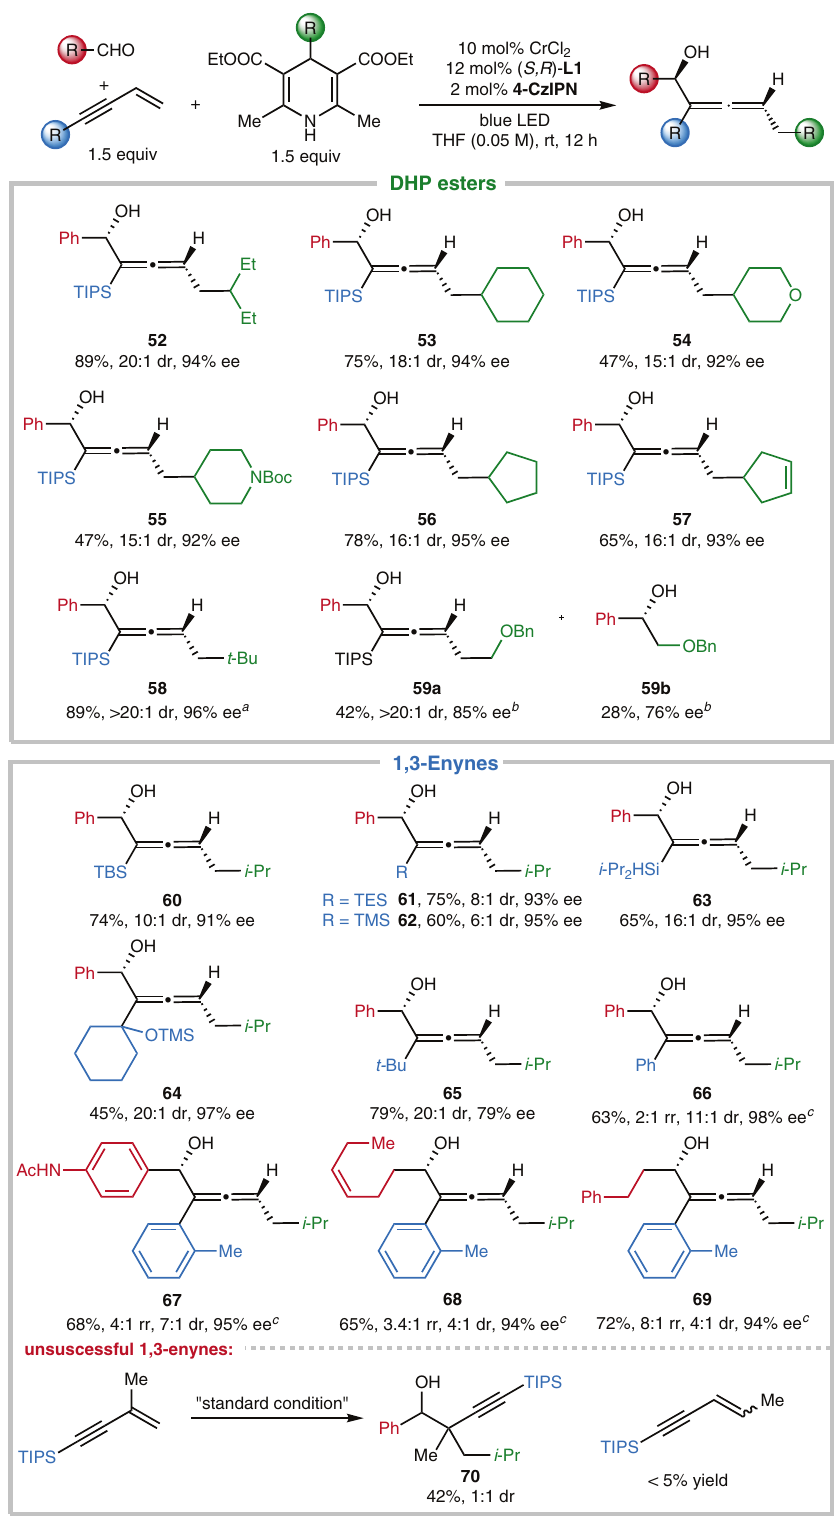
Fig. 4 | The scope of DHP esters and 1,3-enynes in the 1,4-functionalization of 1,3-enynes. a 4-( tert -butyl)-2,6-dimethyl-1,4-dihydropyridine-3,5-dicarbonitrile was used as radical precursor. b 3.0 equiv of corresponding 1,3-enyne were used. c